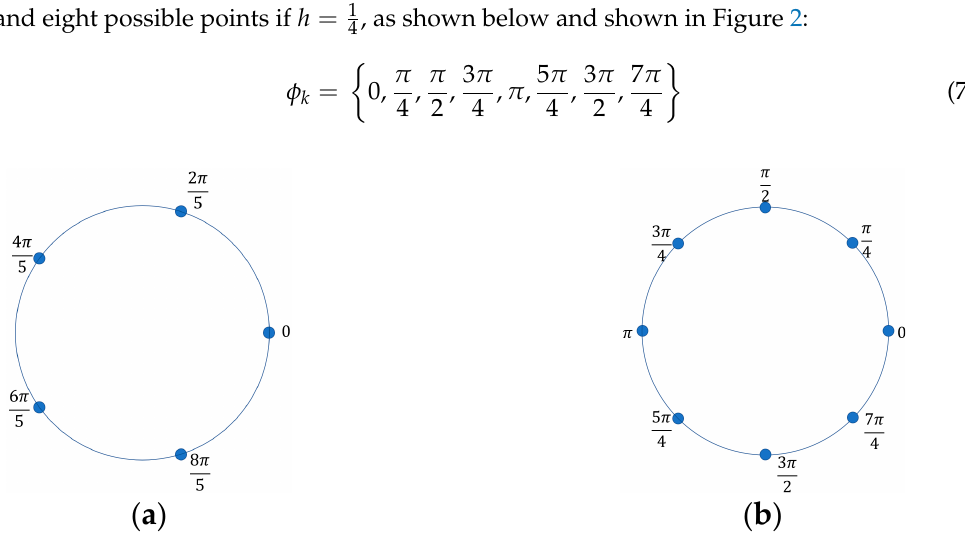
Figure 2. Constellation example for a binary CPM ( a ) ℎ = 2/5 ( b ) ℎ = 1/4.